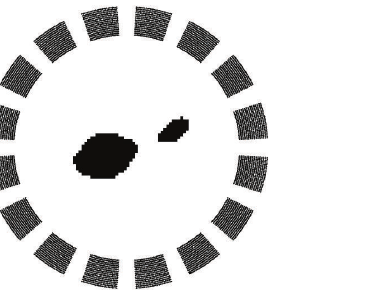
Figure 5: Reconstruction of two objects (left) and a “ghost”